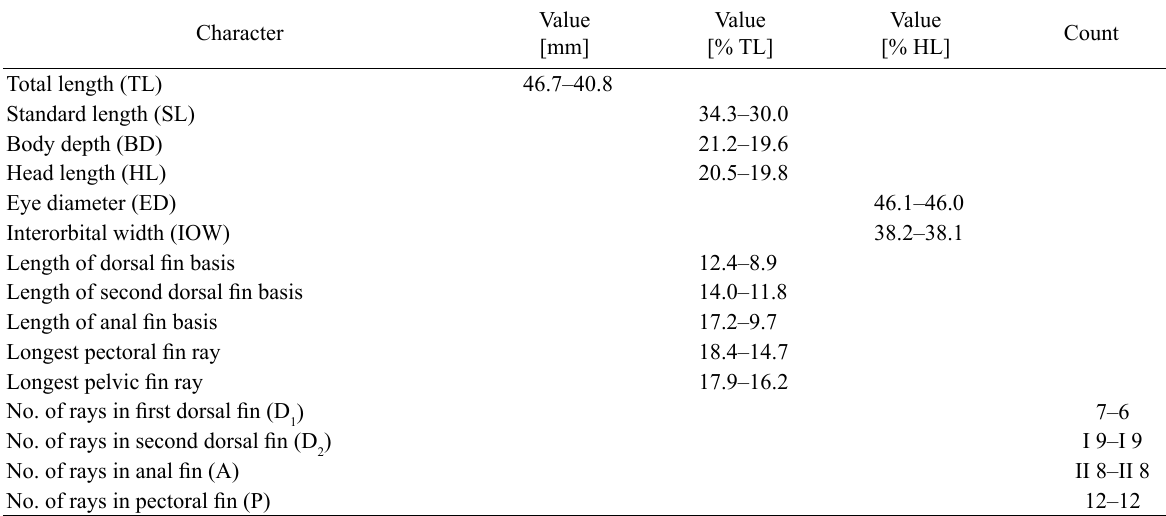
Morphometric and meristic counts for two specimens of the Indian Ocean twospot cardinalfi sh, Cheilodipterus novemstriatus , from Turkish marine